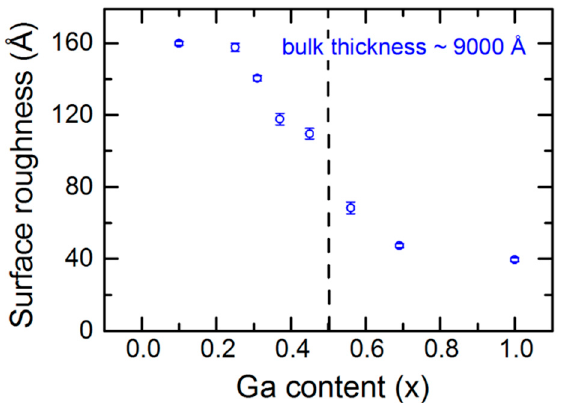
Figure 17. Variation in the IGS surface roughness layer thickness with Ga content x = [Ga]/{[In] + [Ga]} at the endpoint of each deposition near the bulk layer thickness d b ~9000 Å. These surface roughness thickness values are obtained by using the complex dielectric functions of IGS at the end point thicknesses near 9000 Å.